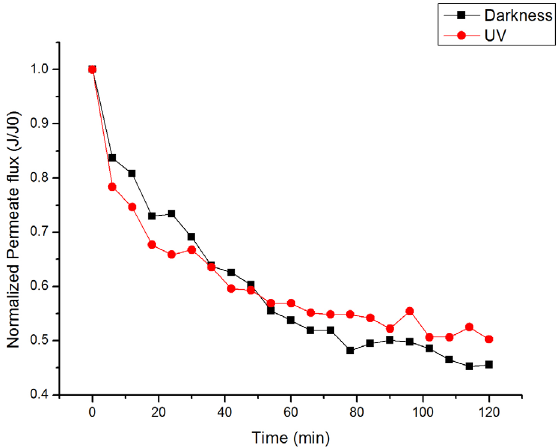
Figure 7. Normalized permeate flux (J/J 0 ) versus time with and without UV for PVDF-PVP-TiO 2 ultrafiltration membrane.